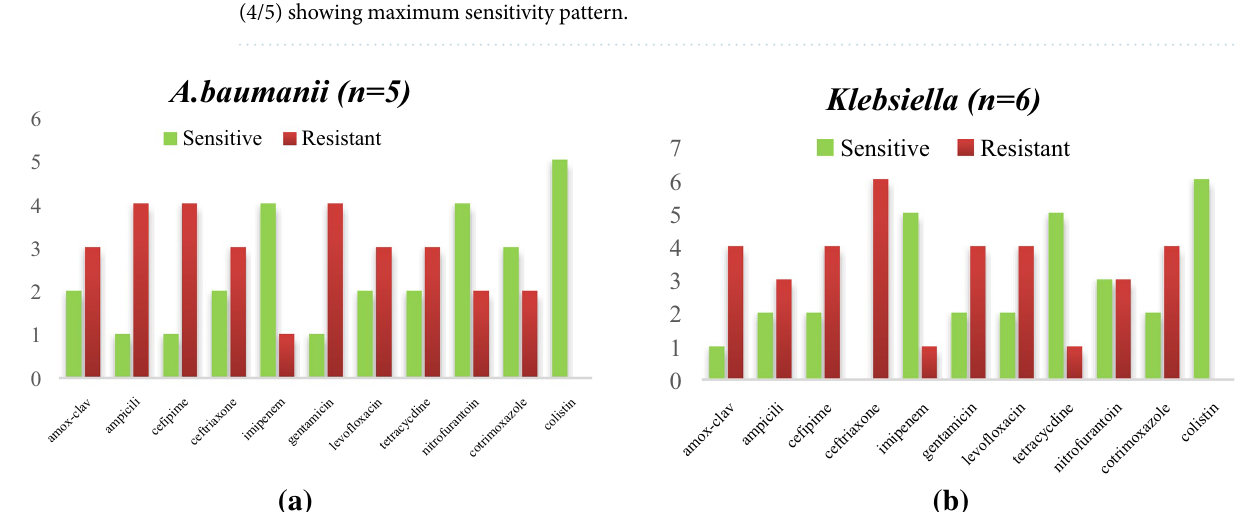
Figure 10. ( a ) Antibiogram A. baumanii isolated from hands of health care workers in NICU. ( b ) Antibiogram of Klebsiella spp. isolated from hands of health care workers in NICU. A good sensitivity pattern was observed for both A. baumanii as well as Klebsiella spp. for colistin (5/5,